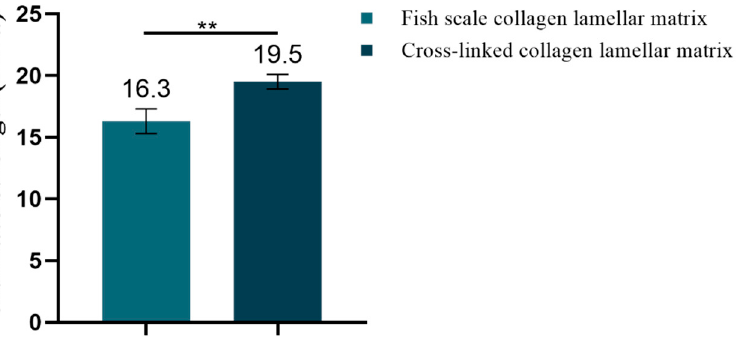
Figure 11. The ultimate strength of fish scale collagen lamellar matrix and cross-linked collagen lamellar matrix ( n = 3). ** p < 0.01.